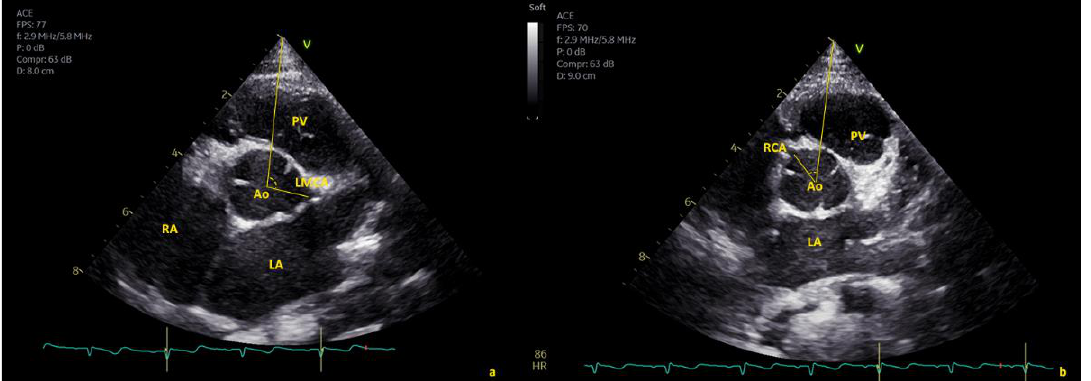
Figure 2. Angle measurement of LMCA ( a ) and RCA ( b ) origin in short-axis view. Ao = aorta, LA = left atrium, PV = pulmonary valve, RA = right atrium.